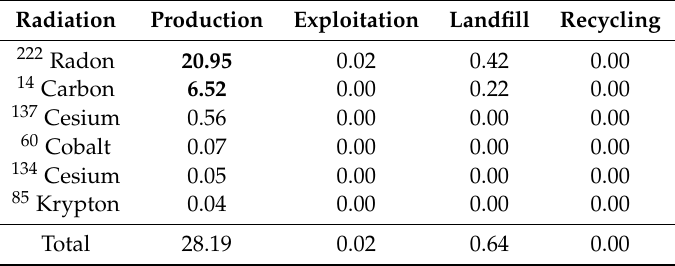
Table 8. Results of grouping and weighting of environmental after-e ff ects for radioactive compounds, occurring in the 1 megawatt photovoltaic power plant [unit: